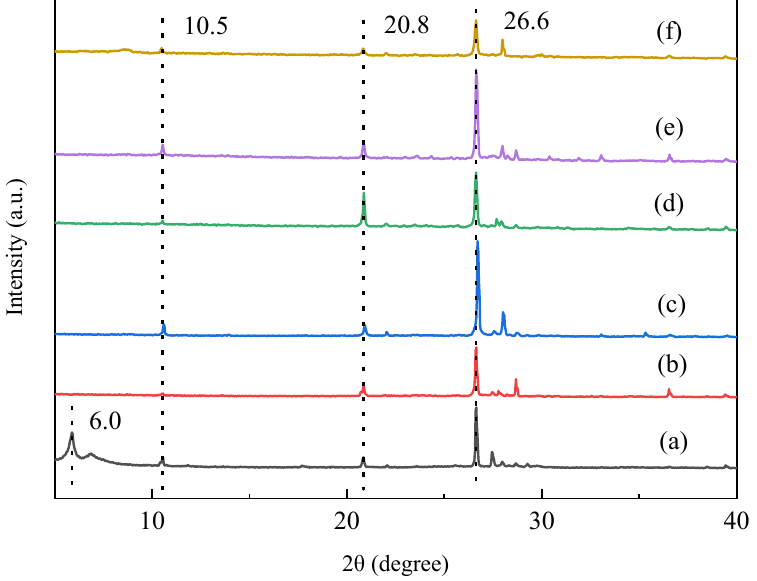
Figure 1. XRD patterns of Vrm (a) Vrm-HS15 (b) Vrm-HS35 (c) Vrm-HC35 (d) Vrm-HP35 (e) Vrm-3rd (f).